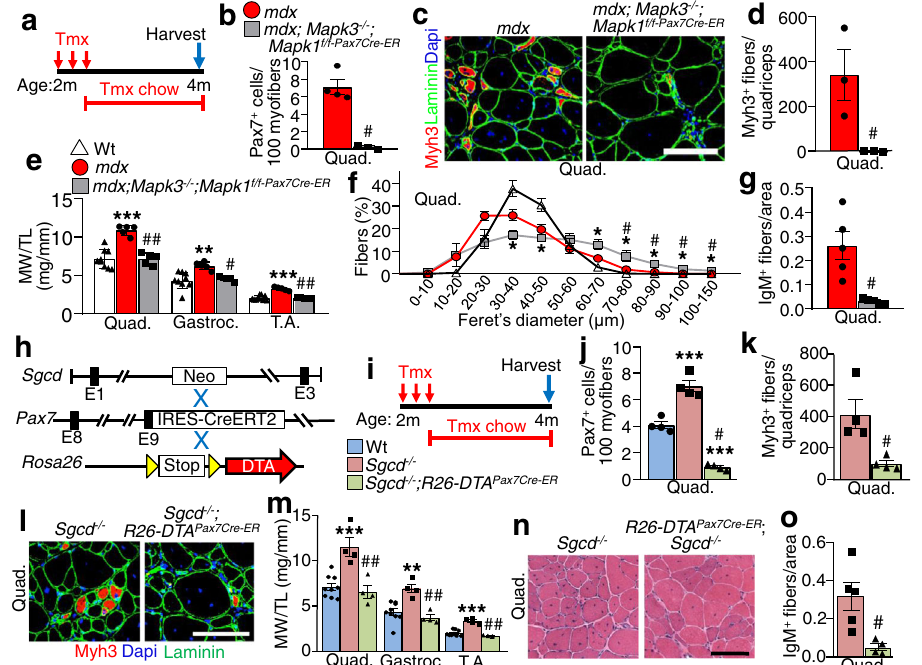
Fig. 3 Satellite cell ablation mitigates disease severity in dystrophic mice. a Schematic representation of the Tmx treatment regimen in mdx mice. Two- month-old mice received daily Tmx injection for 5 days and were subsequently placed on Tmx chow until 4 months of age. b Quanti fi cation of Pax7 + satellite cells from Quad muscle sections from 4-month-old mice of the indicated genotypes. n = 4 mdx mice and n = 3 mdx ; Mapk3 − / − ; Mapk1 f/f-Pax7Cre-ER mice. Signi fi cance was determined using a two-tailed Student ’ s t test, # P = 0.001. c Representative Quad muscle sections immunostained for Myh3 (red) and laminin (green) in 4-month-old mice of the indicated genotypes. Dapi stained nuclei are in blue. Scale bar = 100 μ m. d Quanti fi cation of the number of Myh3 positive myo fi bers in Quad muscle sections of mice with the indicated genotypes. n = 3 mice per group. Signi fi cance was determined using a two- tailed Student ’ s t test, # P = 0.04. e Muscle weights (MW) normalized to tibia length (TL) from mice of the indicated genotypes at 4 months of age. n = 9 Wt mice and n = 5 mdx and mdx ; Mapk3 − / − ; Mapk1 f/f-Pax7Cre-ER mice. A 1-way ANOVA with Tukey ’ s multiple comparisons test was used to determine signi fi cance, ** P < 0.01 vs Wt, *** P < 0.001 vs Wt, # P = 0.01 vs mdx , ## P < 0.001 vs mdx . The 4-month Wt weight data are also shown in “ m ” and in Supplementary Fig. 3b. f Minimal feret ’ s myo fi ber diameter distribution from the Quad muscle of 4-month-old mice with the indicated genotypes. n = 4 Wt mice; n = 3 mdx and mdx ; Mapk3 − / − ; Mapk1 f/f-Pax7Cre-ER mice. A 1-way ANOVA with Tukey ’ s multiple comparisons test was used to determine signi fi cance, * P < 0.05 vs Wt, # P < 0.05 vs mdx . The 4-month Wt feret ’ s diameter data are also shown in Supplementary Fig. 3d. g Quanti fi cation of IgM positive fi bers in quad muscle sections from mice of the indicated genotypes. n = 5 mice per group. Signi fi cance was determined using a two-tailed Student ’ s t test, #